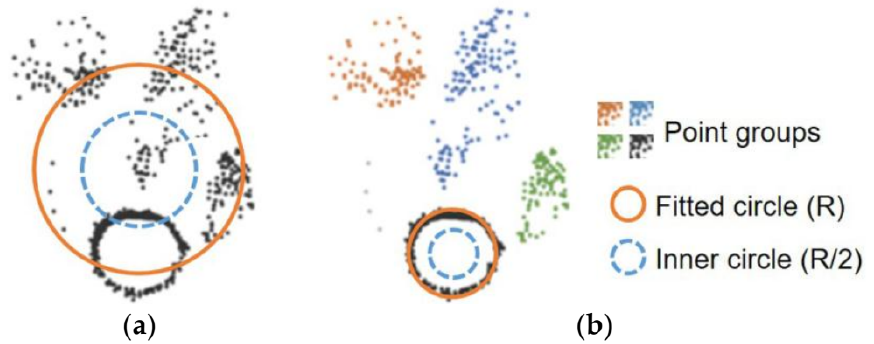
Figure 11. Circle fitting a diameter at breast height (DBH). ( a ) Initial adjustment and inner circle checking; ( b ) Clustering and recalculation of the radius using the larger point